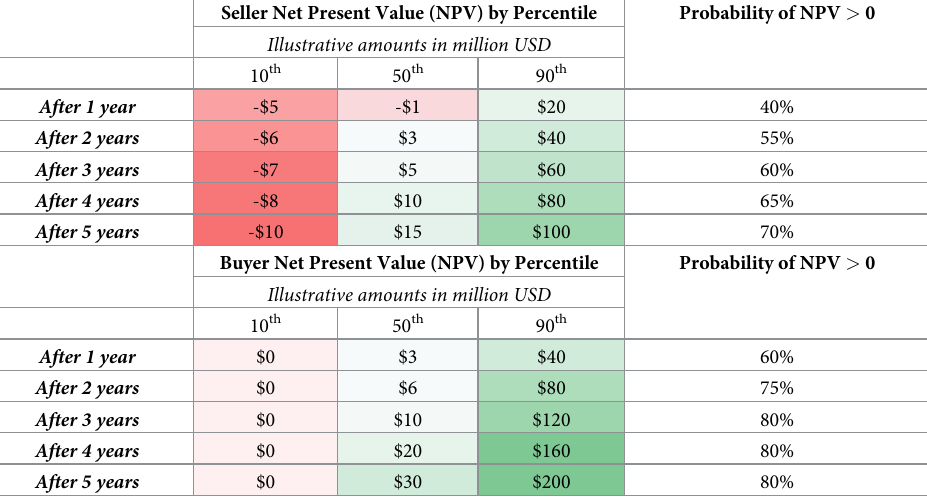
Table 1. Conceptual example of the output from the above CBA framework. Note that the framework will result in two sets of outputs–one for sellers, one for buyers–as depicted above. Seller Net Present Value (NPV) by Percentile